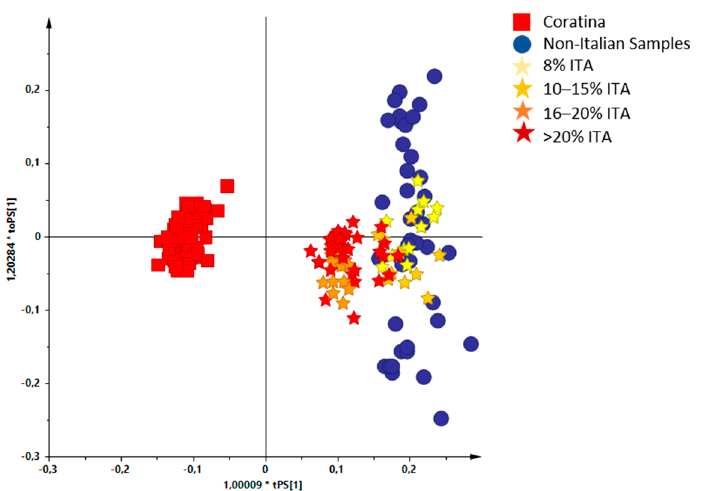
Figure 9. Score plot of the OPLS-DA model for samples of considered organic EU community and non-community oils compared to Coratina and other non-Italian oils; 1 + 1 + 0 components with R 2 X = 0.925, R 2 Y = 0.981 and Q 2 = 0.974.